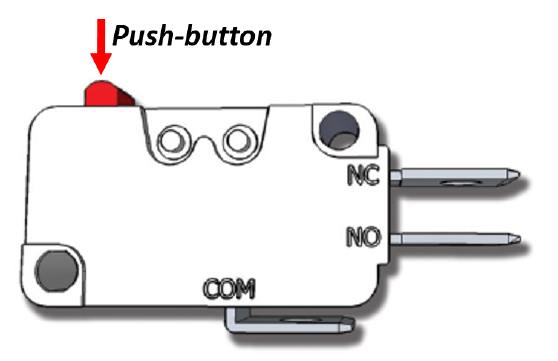
Figure 4. Push-button for DC motor control. Red-dotted line shows the two possible circuit positions depending on the pivot position.